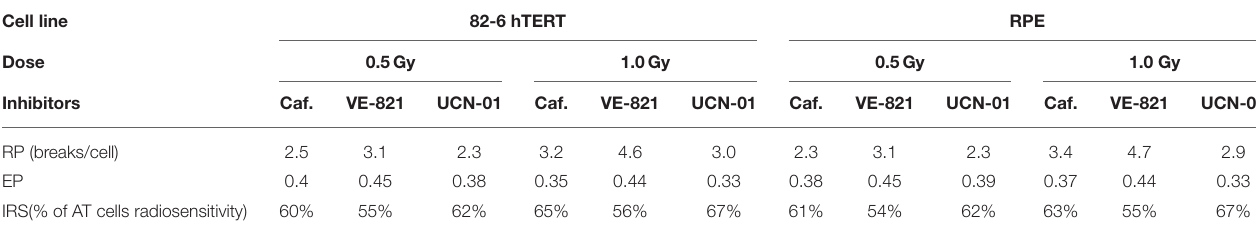
TABLE 1 | G2-assay parameters (1h post-irradiation with 0.5 and 1Gy). Cell line 82-6 hTERT RPE Dose 0.5Gy 1.0Gy Inhibitors Caf. VE-821 UCN-01 Caf. VE-821 UCN-01 Caf. RP (breaks/cell) EP IRS(% of AT cells radiosensitivity) 60%